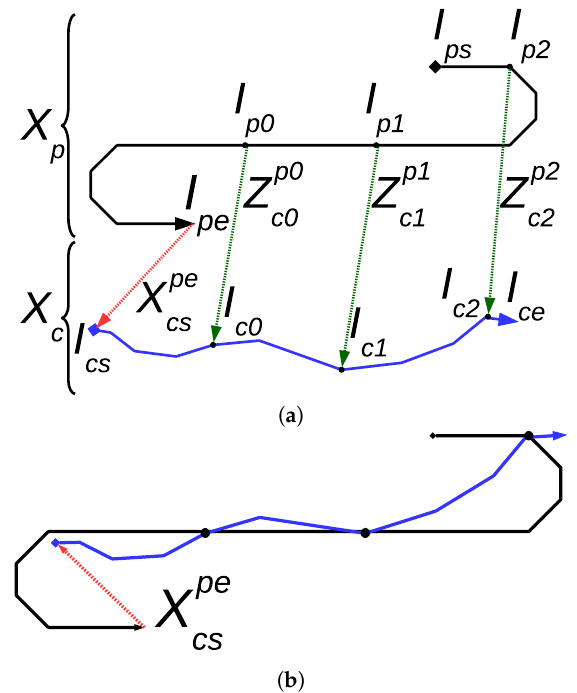
Figure 5. ( a ) Summary of the map joining and ( b ) an example of a joined